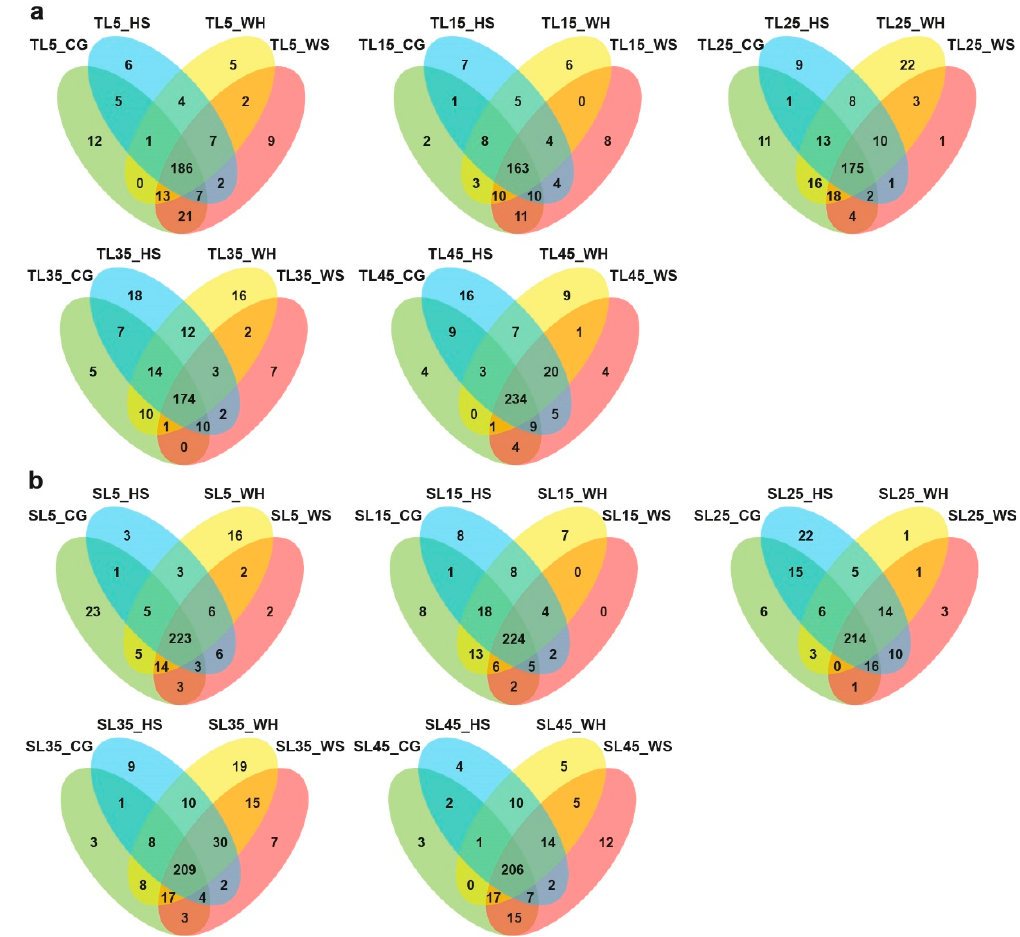
Figure 1. Venn diagrams of durum wheat microRNAs (miRNAs) identified between different biological groups. ( a ) miRNAs specific to treatment groups at each time-point in DBA Aurora. ( b ) miRNAs specific to treatment groups at each time-point in L6. TL, libraries made from leaf tissue of the stress-tolerant genotype DBA Aurora. SL, libraries made from leaf tissue of the stress-sensitive genotype L6. 5, 15, 25, 35, 45 indicate treatment time-points (days post-anthesis). CG, control group. WS, water-deficit stress group. HS, heat stress group. WH, water-deficit plus heat stress group.